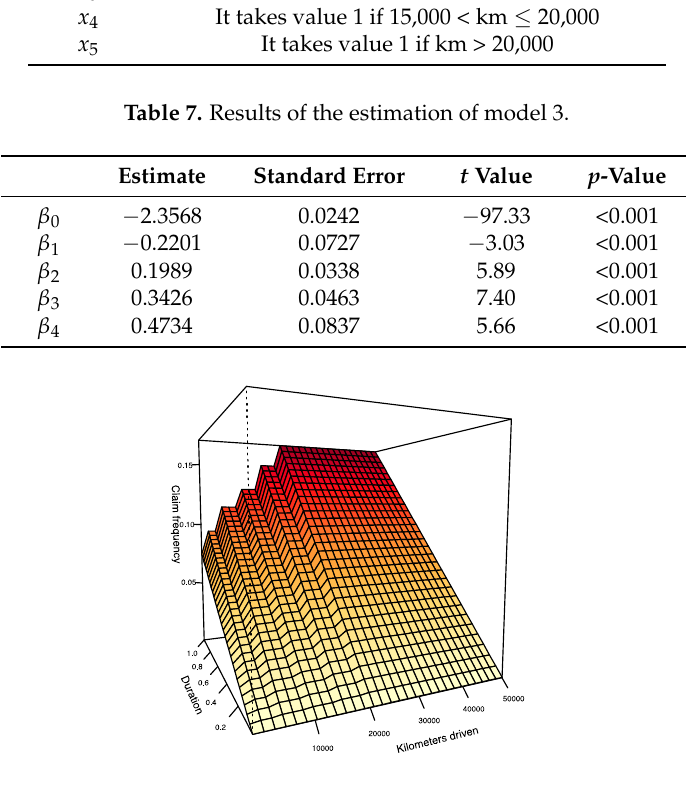
Figure 13. Model 3 (GLM). Predictions surface for claims not at fault with property